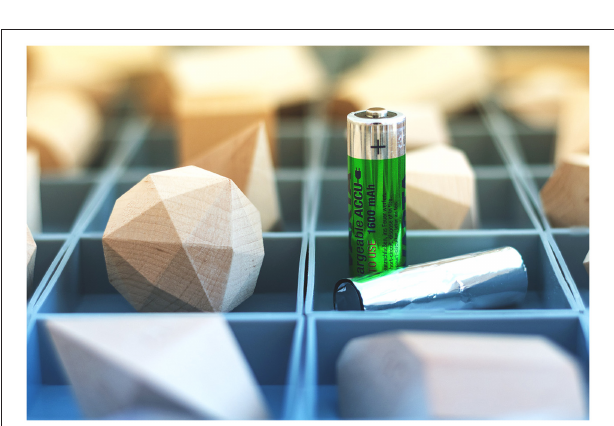
FIGURE 10 | Using crystallography, crystallographic databases, and data mining with crystallochemical methods for the identification of novel aluminum ion conductors (positive electrodes and solid